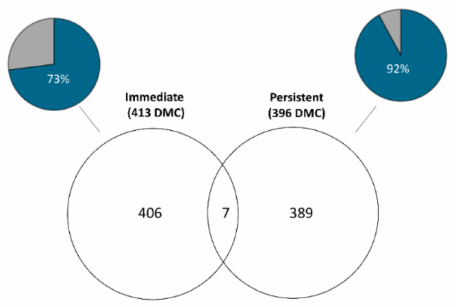
Figure 6. Venn diagram of hepatic DMCs that overlap between Immediate and Persistent time-points. Pie charts indicate the proportion of the DMCs that met coverage criteria (blue) in order to be considered for DMC analysis in both time-points, the proportion of DMCs in grey were not tested in both time-points.